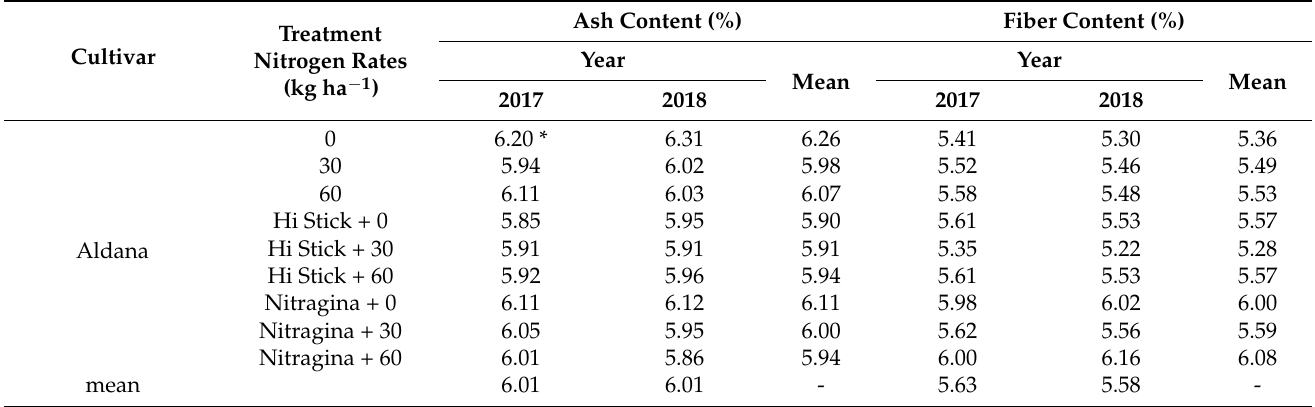
Table 8. Ash and fiber content in dry matter of the soybean seeds depending on the mineral N fertilization applied and the